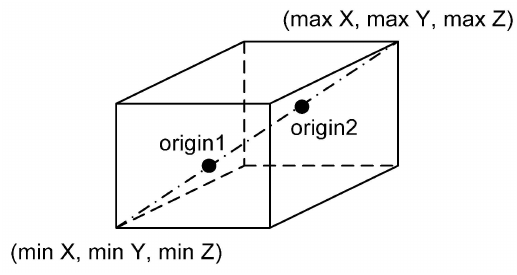
Figure 5. Locations of two origins.